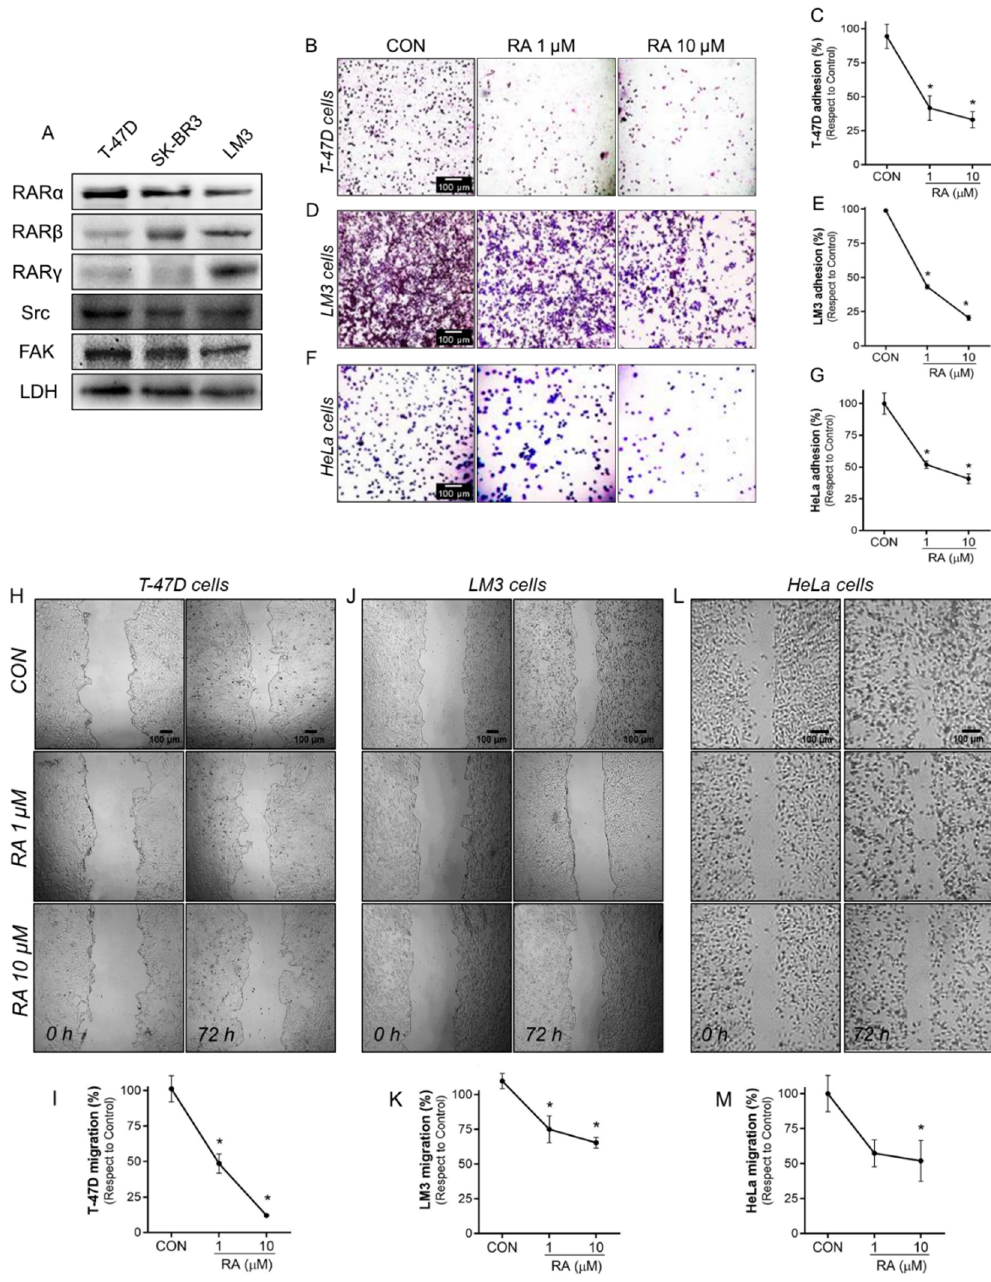
Figure 2. RA reduces cancer cell adhesion and migration. ( A ) Whole-cell lysates from human BC cell lines T-47D, SK-BR3, and a murine BC cell line LM3 were evaluated to determine the expression of RAR α , RAR β , RAR γ , Src and FAK by western blot assay. LDH expression was used as a protein loading control. A representative blot is shown. ( B , C ) T-47D, ( D , E ) LM3, and ( F , G ) HeLa cells were treated with RA (1–10 µ M) treatment for 72 h. After the treatment, cells were seeded into 96-well plates previously covered with gelatin and a cell adhesion assay was performed. Representative images and percentages of adhered cells are shown. ( H , I ) T-47D, ( J , K ) LM3 and ( L , M ) HeLa cells were exposed to RA (1–10 μ M) for 72 h and cell migration by wound-healing assay was performed. Representative images are shown. Gap closure was quantified by the use of the ImageJ software. Adhesion and migration values are presented as a percentage of control. * = p < 0.05 vs. control, CON. All experiments were performed in triplicates with consistent results.